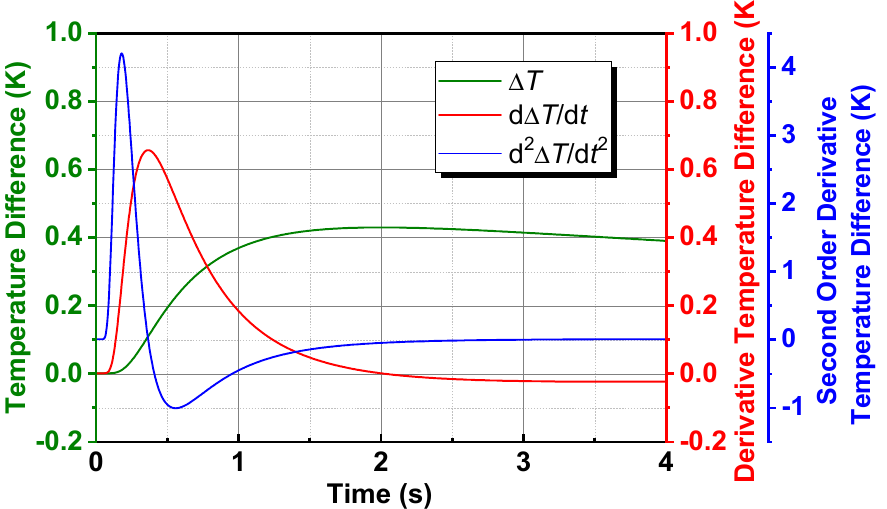
Figure 3. Temperature difference over time and its first and second derivative.